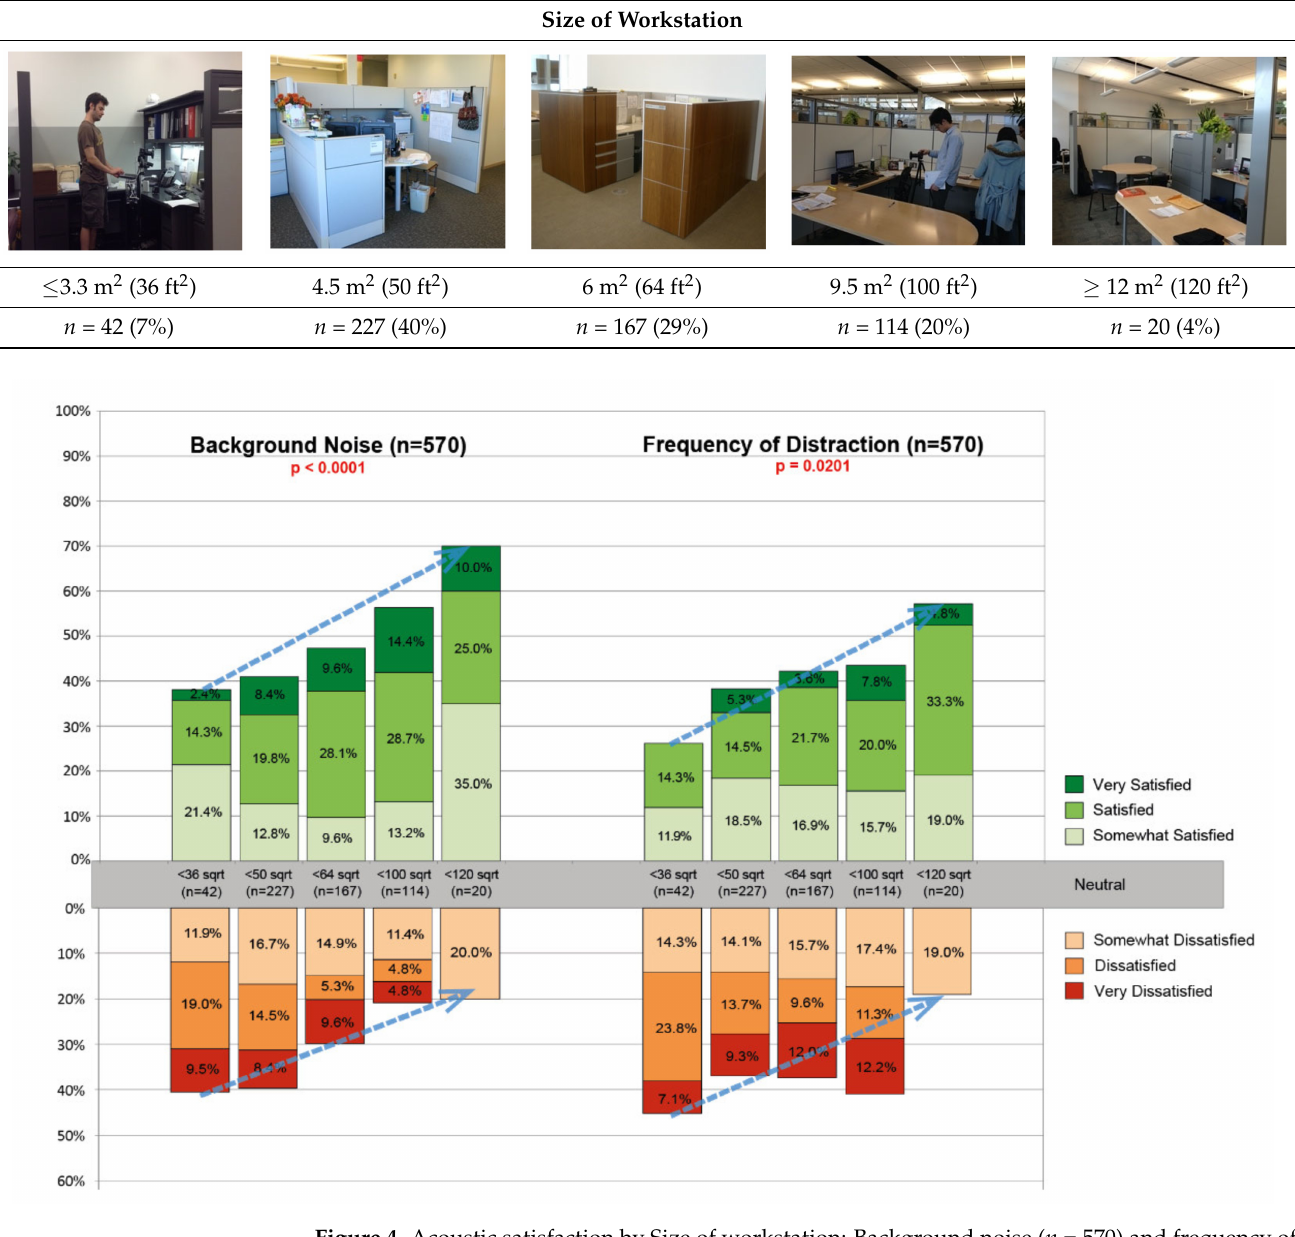
Figure 4. Acoustic satisfaction by Size of workstation: Background noise ( n = 570) and frequency of distraction ( n = 570) in open-plan